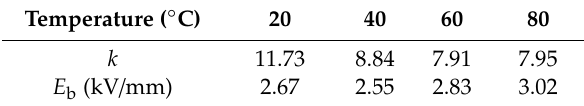
Table 7. The non-linear coefficient k and the threshold field E b of the sample at different temperatures with α -SiC content of 150 phr.